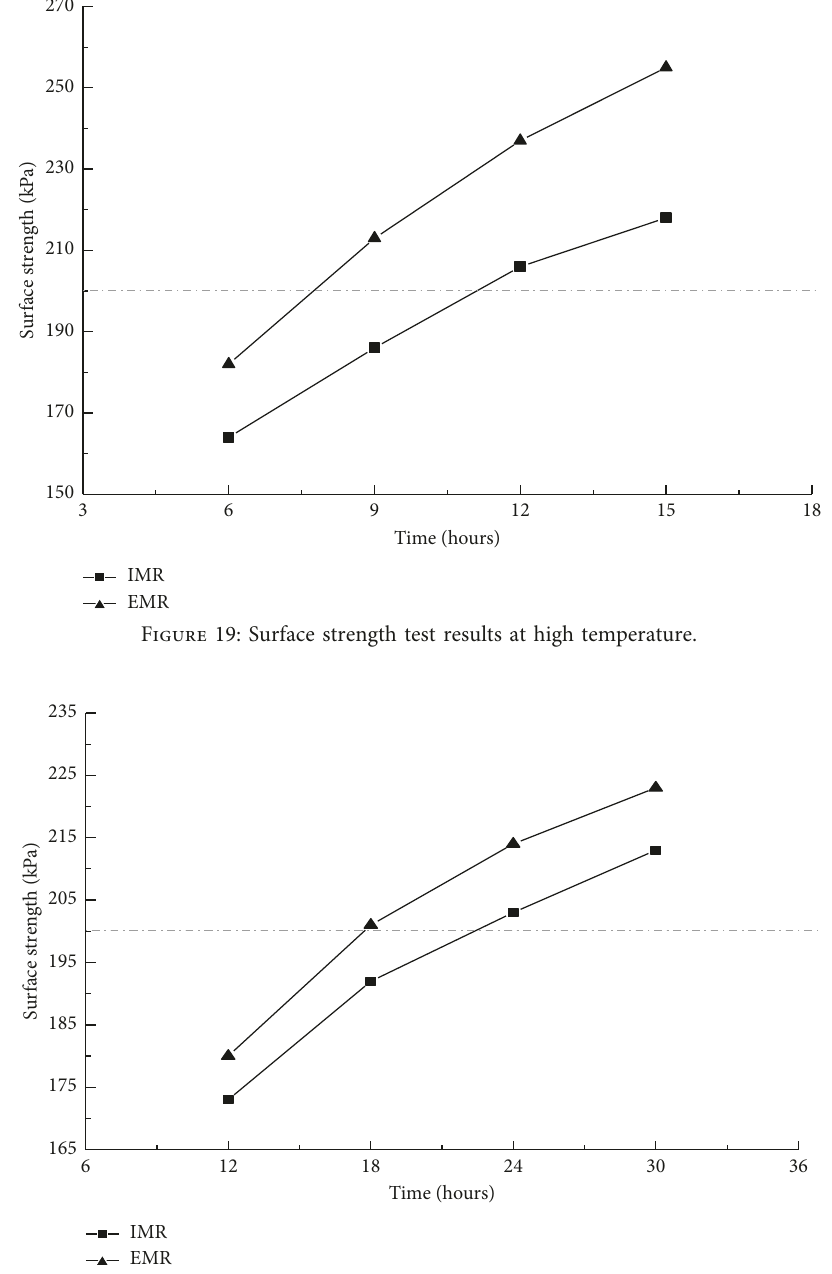
Figure 20: Surface strength test results at a low